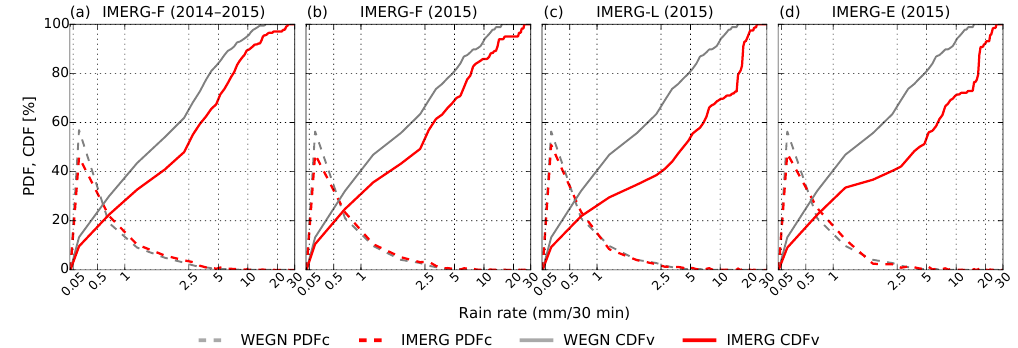
Figure 4. Occurrence probability density function of rain rates (PDF c , dashed) and cumulative distribution functions of rain volume (CDF v , solid) for WEGN (gray) and IMERG (red). Comparisons are shown for IMERG-F over the full 2014–2015 period (a) and separately for IMERG-F (b) , IMERG-L (c) , and IMERG-E (d) over the 2015 period.